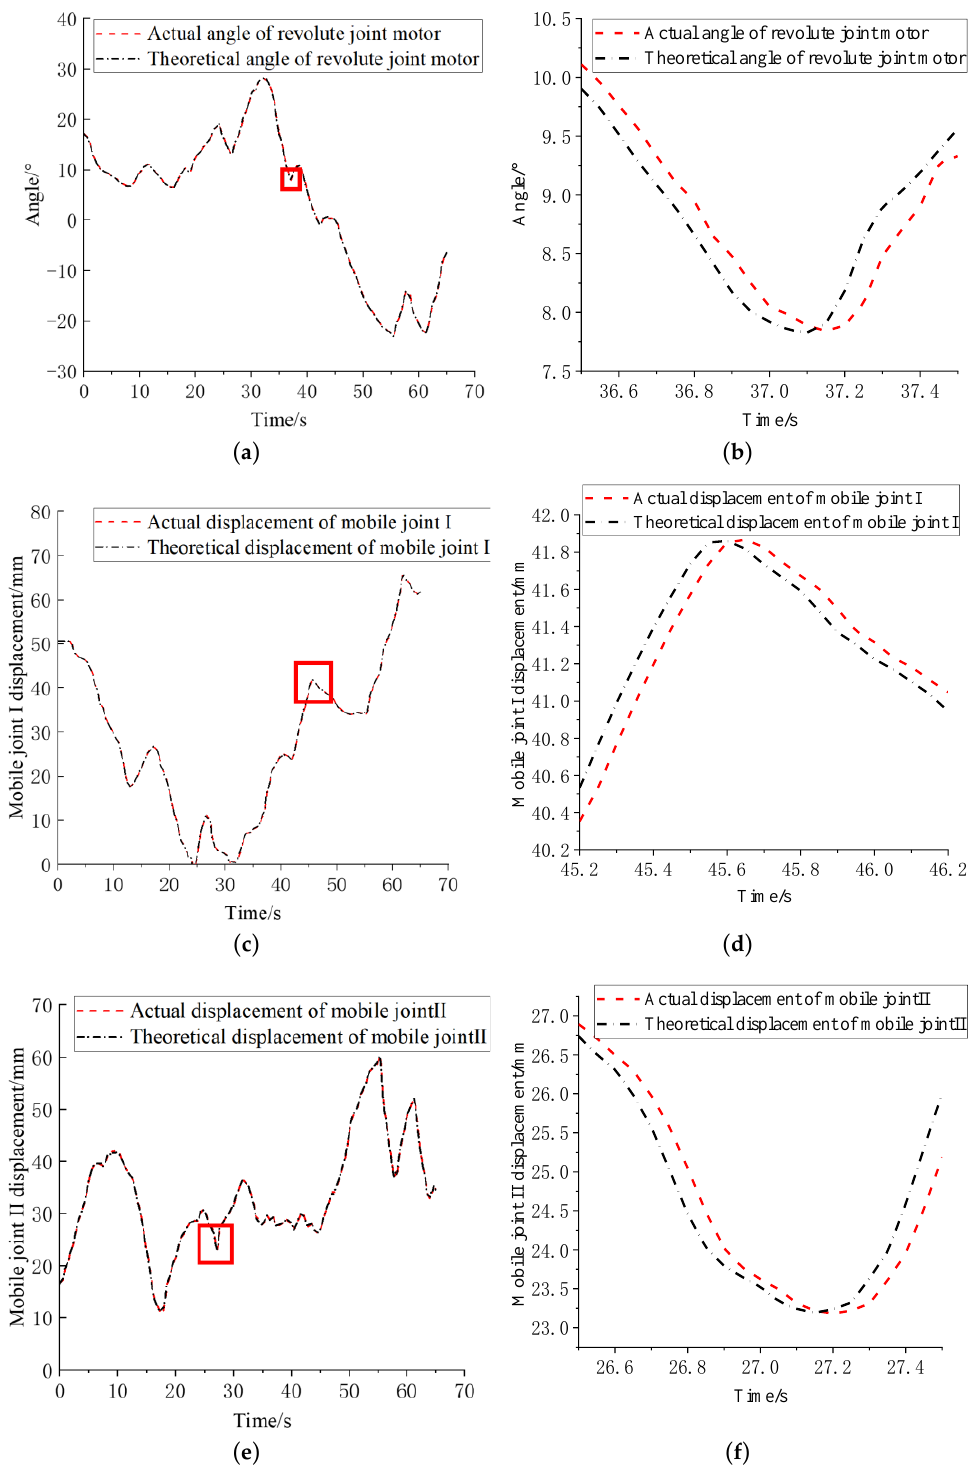
Figure 18. Robotic arm joint tracking effect where zoom in takes place in red boxes. ( a ) Revolute joint tracking effect. ( b ) Enlargement of revolute joint tracking effect. ( c ) Mobile joint I tracking effect. ( d ) Enlargement of mobile joint I tracking effect. ( e ) Mobile joint II tracking effect. ( f ) Enlargement of mobile joint II tracking effect.